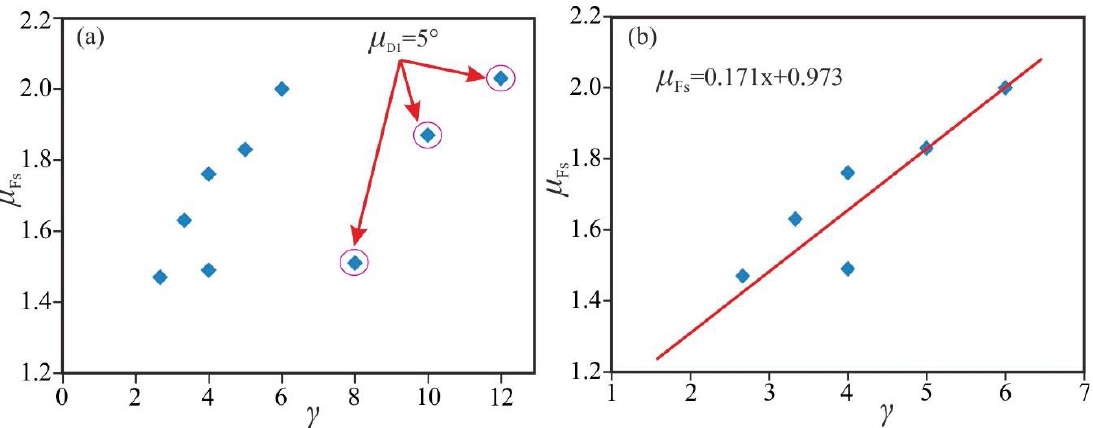
Figure 10. Influence of the γ on µ Fs (( a )—the scatter plot of µ Fs relative to nine Case; ( b )—the scatter plot of µ Fs relative to six Case, excluding Cases 3, 6 and 9). Note: the blue boxes are the values of µ Fs corresponding to certain γ ; the red line in ( b ) is the fitted curve.